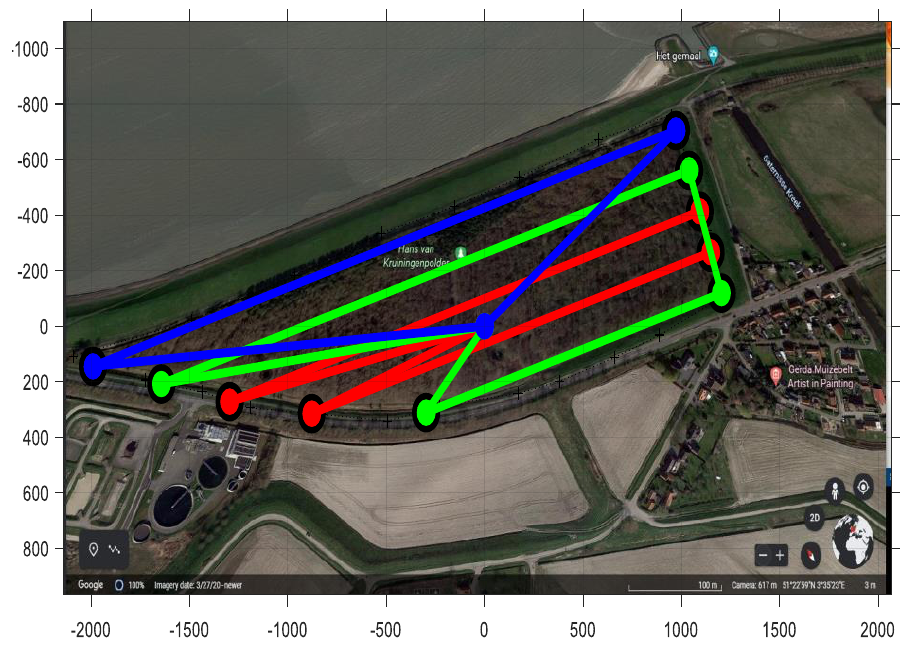
Figure 8. Flight Path for the UAVs.